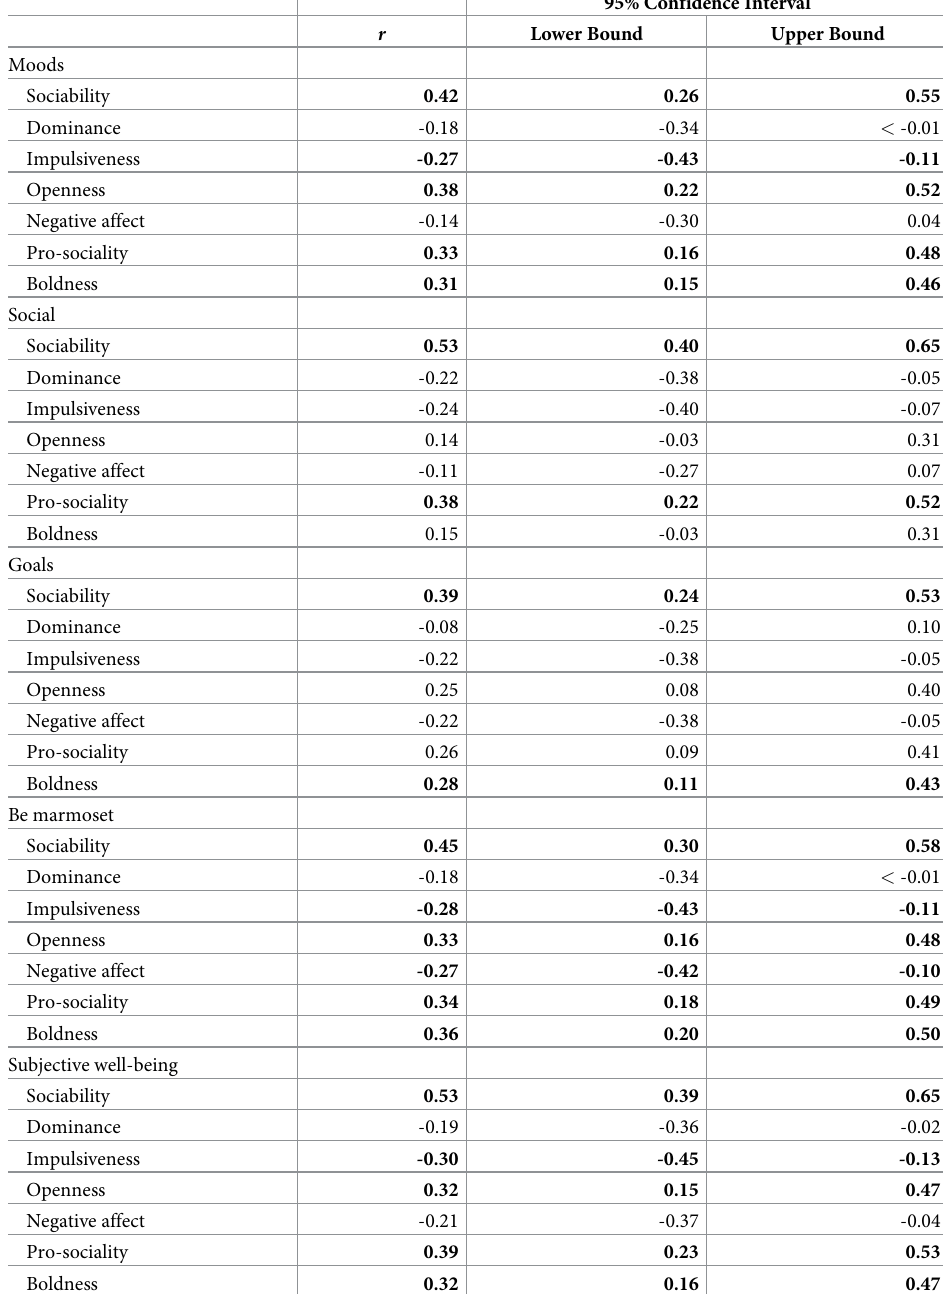
Table 8. Correlations between personality and the subjective well-being items and factor.